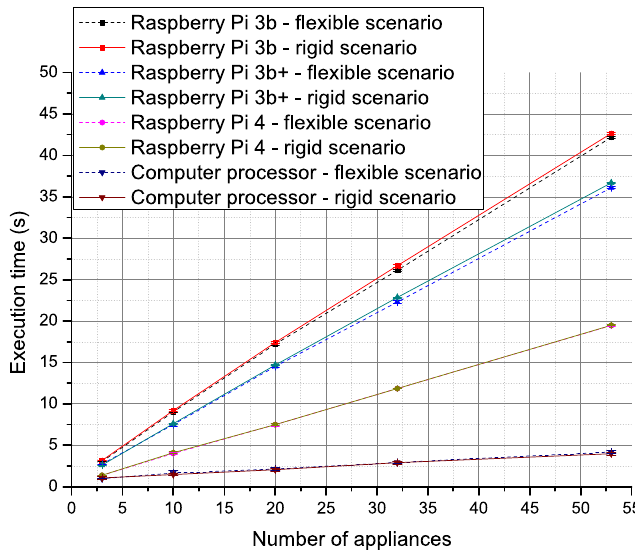
Figure 9. Total computational cost for two consumers in different settings regarding the number of appliances: comparison between Scenarios I and II on pilot deployment and computer simulation.